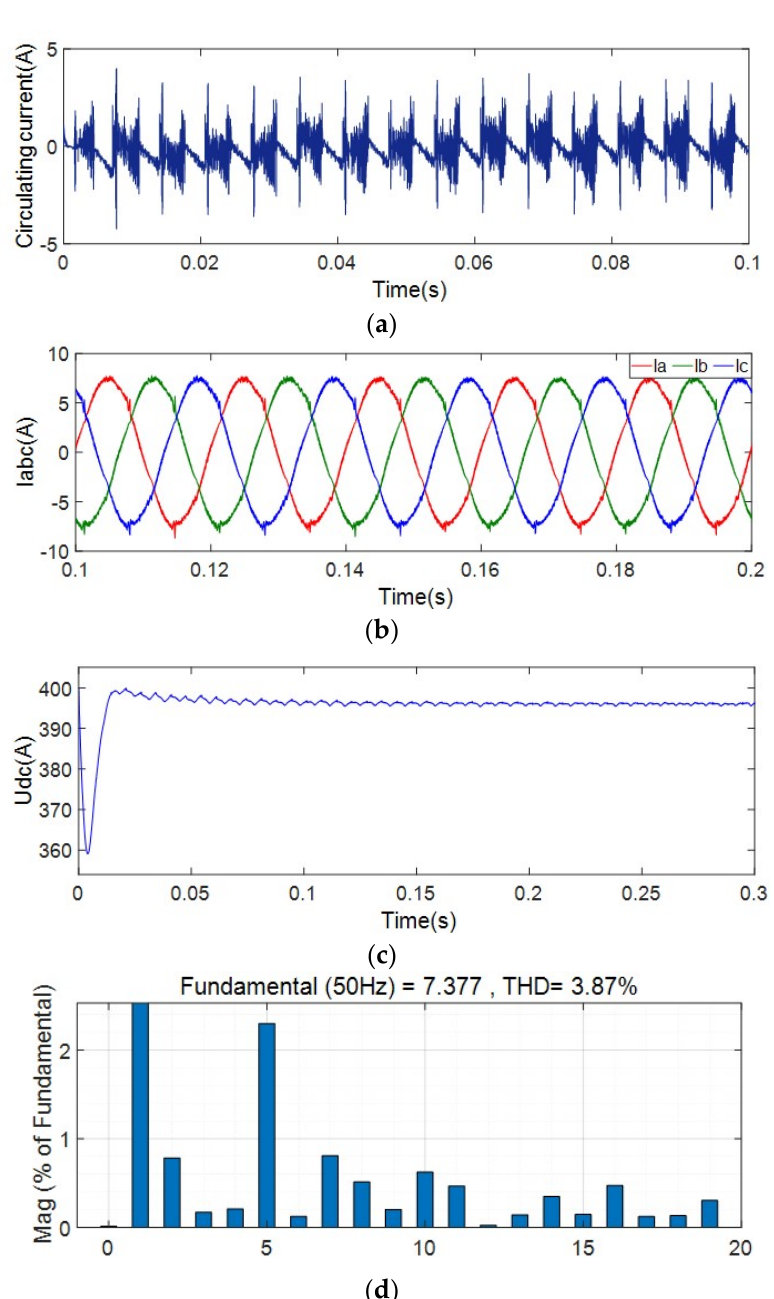
Figure 12. Adding a control scheme for suppressing circulating current when the inductance parameters of the AC side are different ( a ) Positive DC bus circulating current. ( b ) AC side current. ( c ) DC side output voltage. ( d ) THD of AC side current.